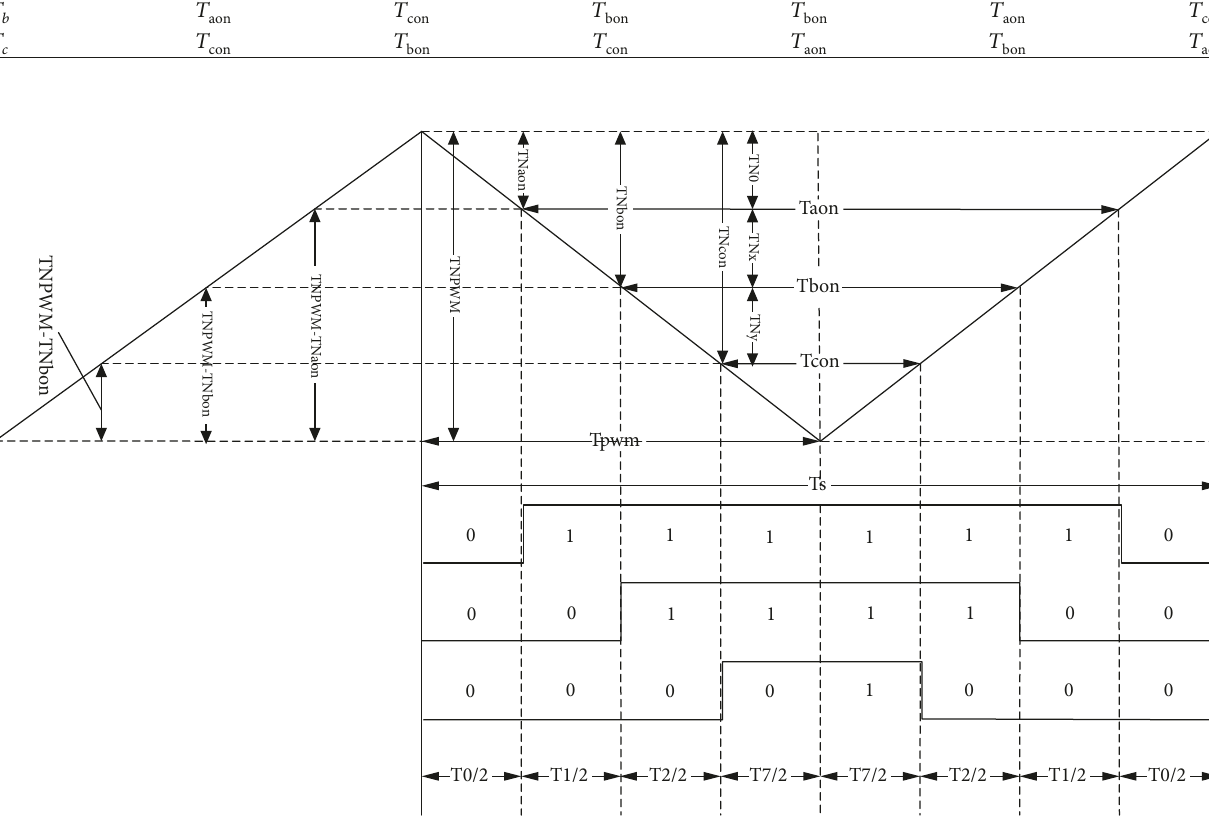
Figure 11: Operation relationship when 𝑈 ref is in sector I.